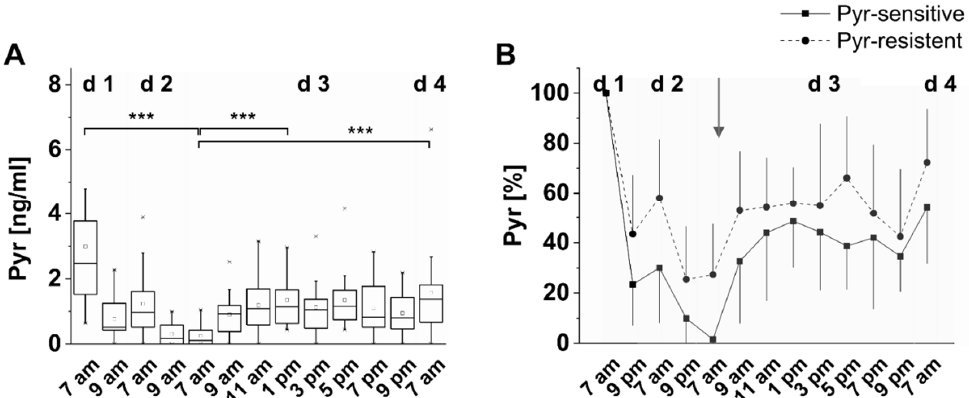
Figure 4. Interindividual differences in the metabolic transit of 1.2 mg dietary Pyr from food to saliva. ( A ) Boxplot of salivary Pyr concentrations after a high MRP intervention meal during a three-day low MRP diet of 17 subjects. The box contains 50% of data and includes the mean of the data (demonstrated by the square in the box) and the median (demonstrated by the line in the box). The length of the box, the interquartile range, is equivalent with the variation of the data. The whiskers within plots show a range of 1.5-fold values of the interquartile range. Outliers are indicated by an asterisk. Significance: *** p < 0.001. ( B ) classification of subjects corresponding to the degree of decrease of salivary Pyr concentration during low MRP diet in two subgroups of “Pyr-sensitive metabolizers”(squares) and “Pyr-non-sensitive metabolizers”(dots). Shown are the mean values with one-sided standard deviation. The arrow indicates the time of intervention.